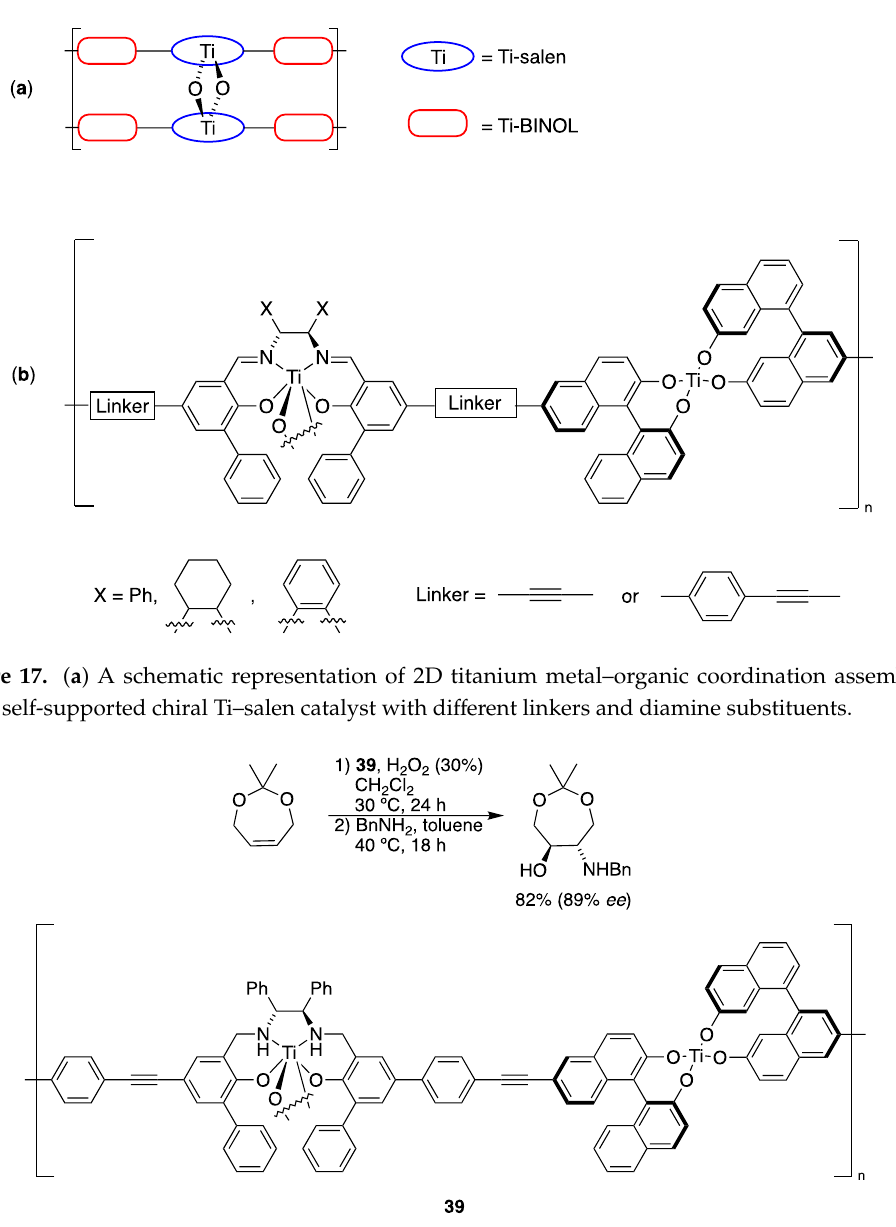
Scheme 13. The sequential asymmetric epoxidation/ring-opening of 2,2-dimethyl-4,7-dihydro-1,3-